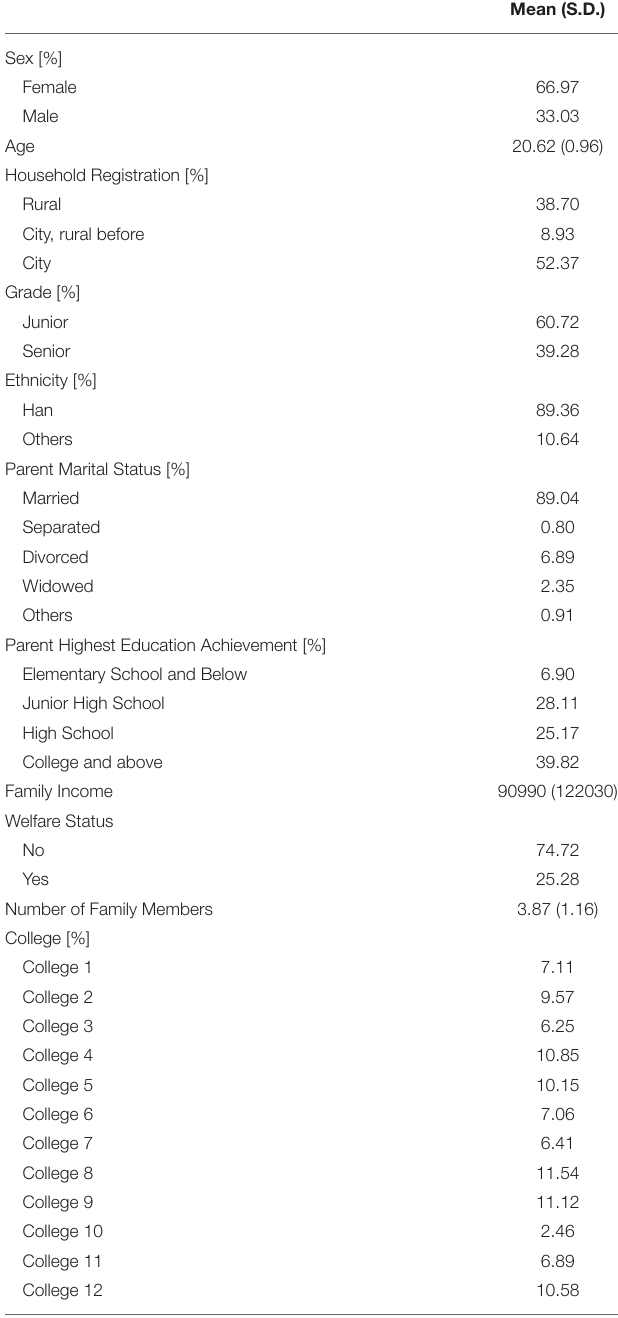
TABLE 1 | Descriptive statistics of sampled